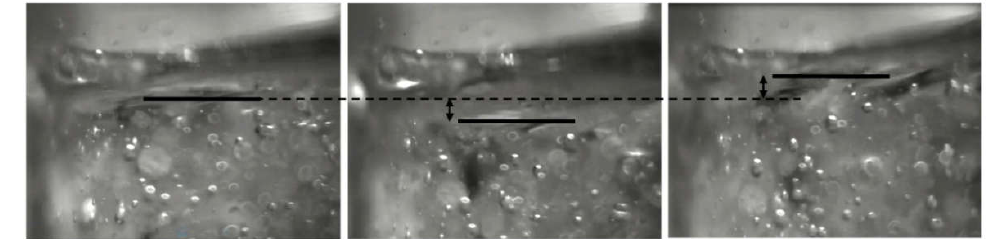
Figure 5. Oscillation (up and down motion) of the free-surface of the liquid with time produced by the periodic bubbling.